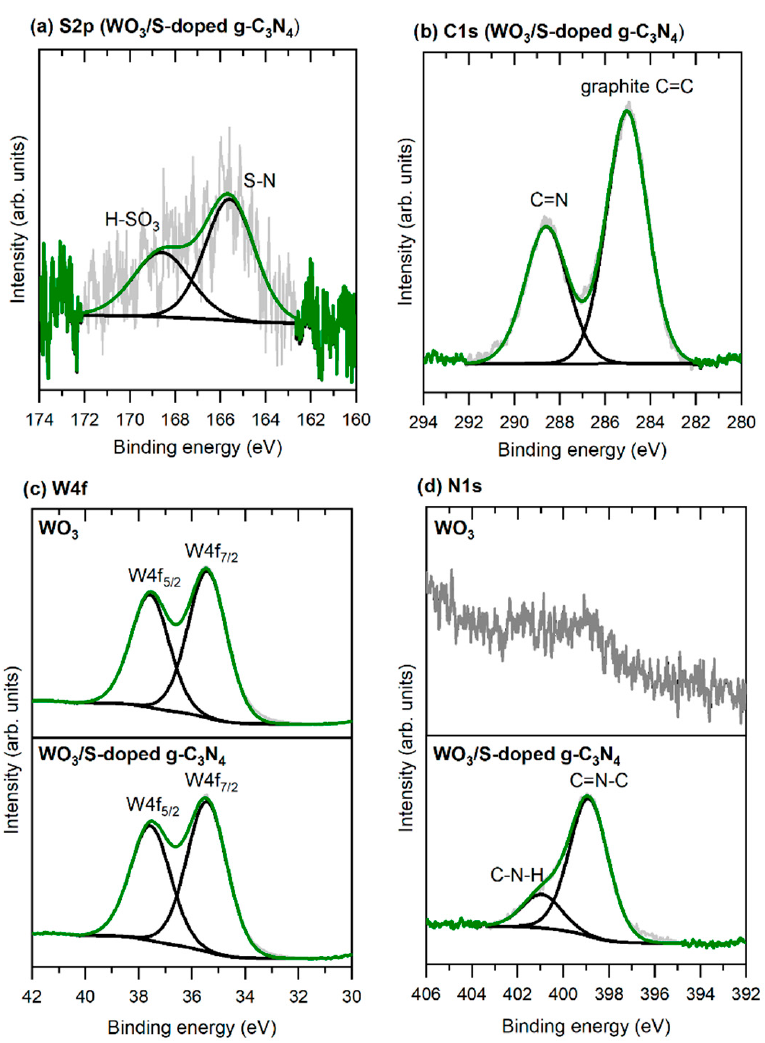
Figure 5. XPS spectra of ( a ) S2p, ( b ) C1s, ( c ) W4f, and ( d ) N1s signals for WO 3 and WO 3 /S-doped g- C 3 N 4